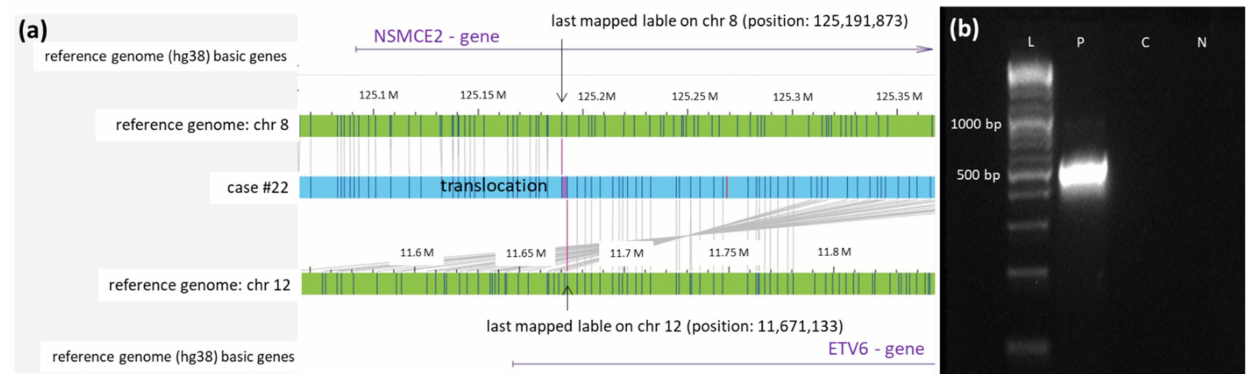
Figure 4. Validation of the newly identified translocation t(8;12) in case #22 detected by OGM. ( a ) Schematic representation of the newly identified translocation t(8,12) in case #22 detected by OGM. The first bar represents the reference genome (hg38) basic genes of chromosome 8 located at the depicted position ( NSMCE2 ). The second and fourth bars (green) show the reference genome map of chromosome 8 and chromosome 12. The third bar (blue) represents the map of case #22. The fifth bar represents the reference genome (hg38) basic genes of chromosome 12 located at the depicted position ( ETV6 ). Vertical blue lines represent mapped labels. ( b ) Validation of the translocation t(8;12) in case #22 via PCR. PCR was performed using forward and reverse primers (see Table S1), generating a product of 513 bp spanning translocation t(8,12) (ranging from position 125,191,873 on chromosome 8 to position 11,671,133 on chromosome 12). The healthy control-DNA and the negative control were both negative in the PCR. Abbreviations: C = control-DNA; chr = chromosome; hg38 = human genome project 38; ETV = ETS variant transcription factor 6; NSMCE2 = SMC5-SMC6 complex SUMO ligase; L = length marker; N = negative control (H2O); P = sample from case #9 collected at diagnosis.